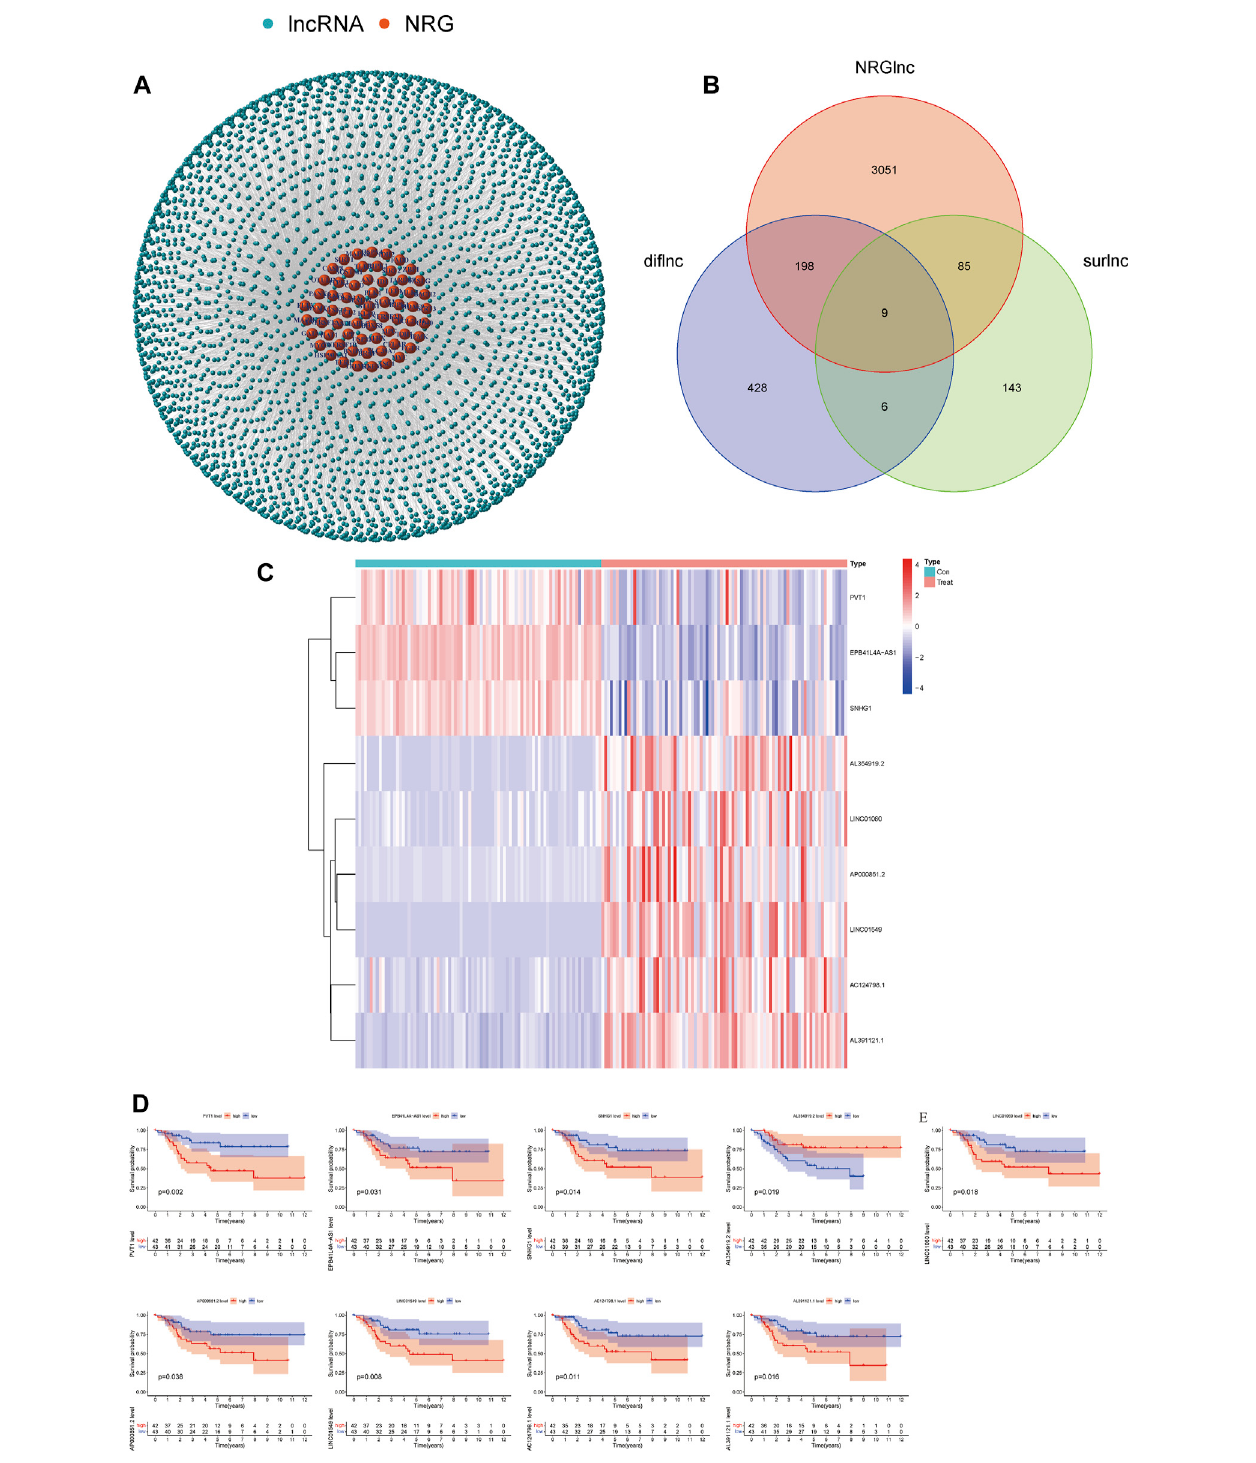
FIGURE 1 | Screening of necroptosis-related lncRNAs. (A) Necroptosis-related lncRNA – mRNA co-expression network diagram. (B) Venn diagram of necroptosis-related lncRNA, prognosis-related lncRNAs, and differential lncRNAs. (C) Expression pro fi les of nine prognostic lncRNAs. (D) Survival curve of nine prognostic